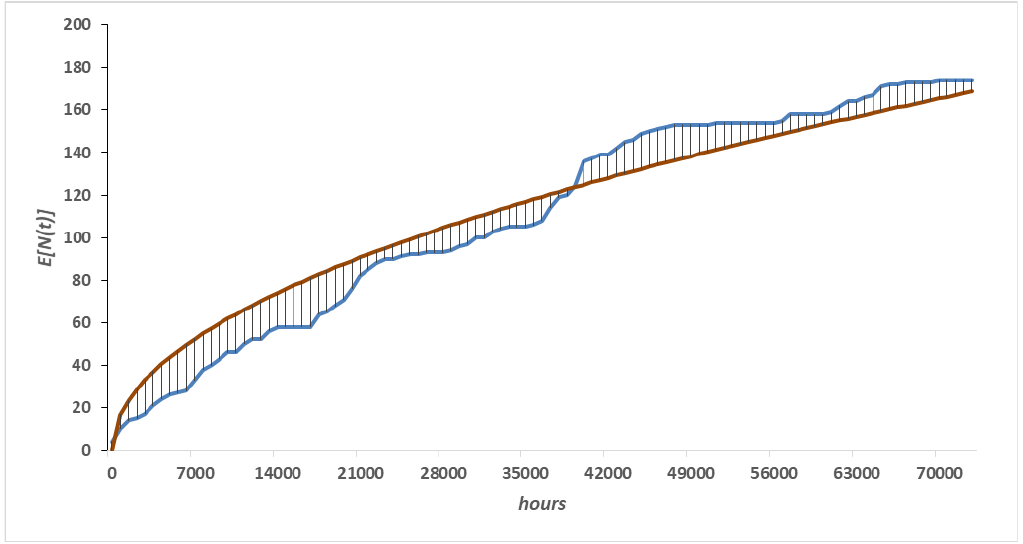
Figure 4. Square root of x simple regression model of the escalator number 4.